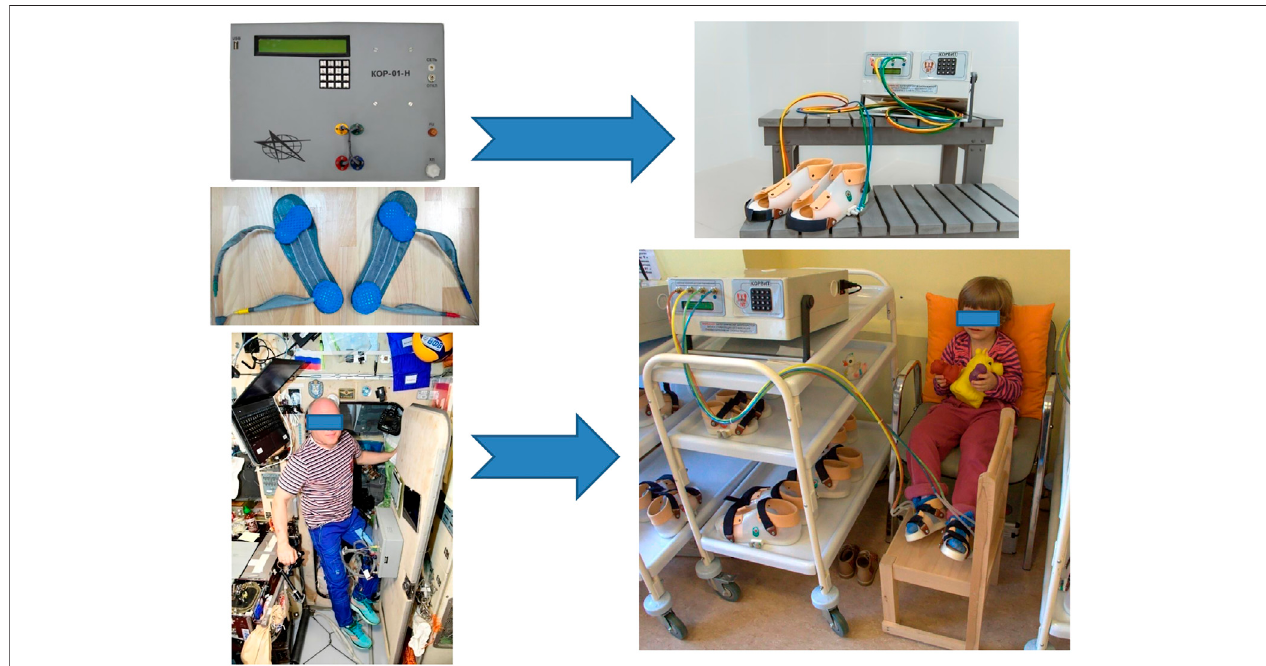
FIGURE 2 | Compensator of support unloading. On the left — space device “ KOR ” and its application on board the International Space Station; on the right – its clinical version “ KORVIT ” (Center of Aviaspace Medicine and Technologies, Russia) used for rehabilitation of patients. Photo credit IBMP.